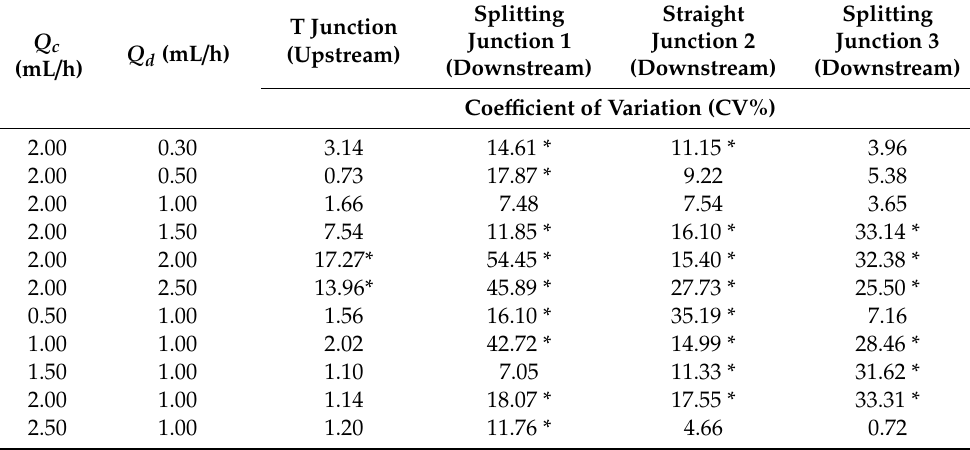
Table 1. Coe ffi cient of variation (CV%) of e ff ective droplet diameters in symmetrical multifurcated channels at di ff erent flow